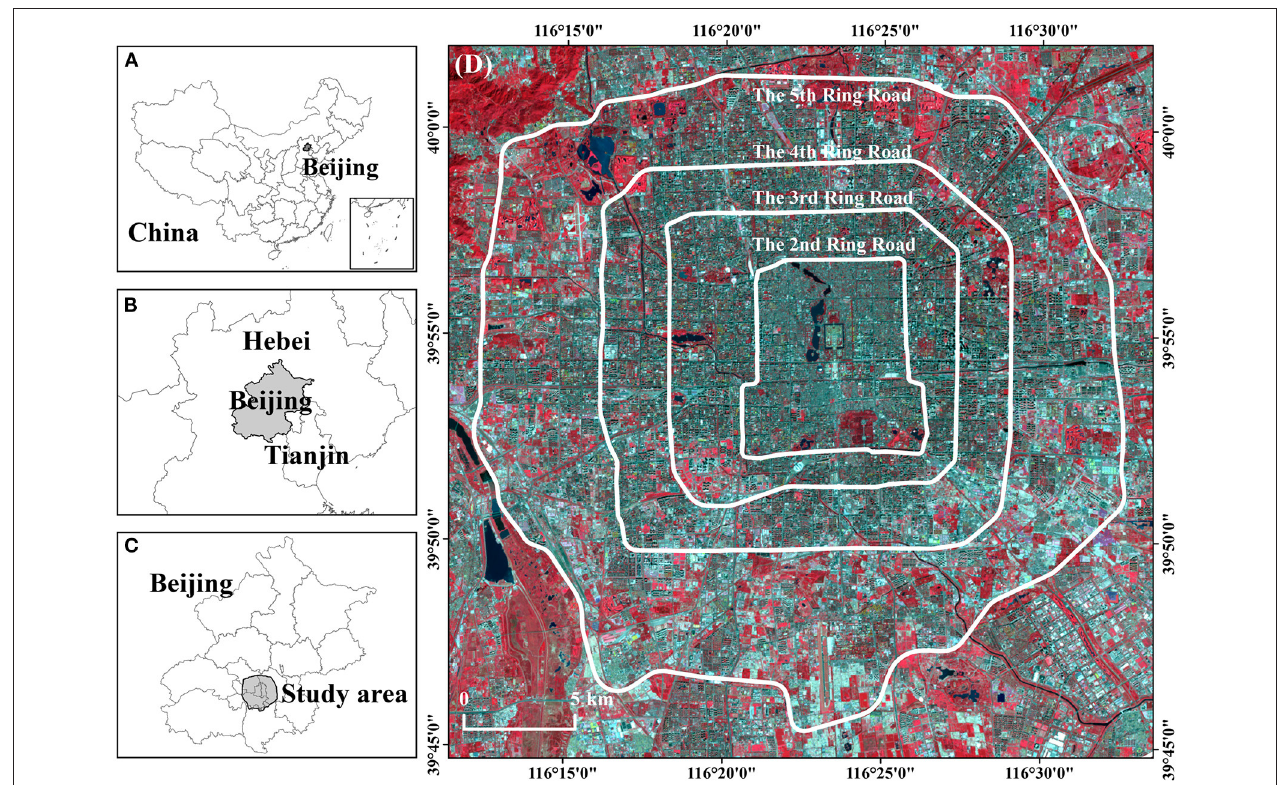
FIGURE 1 | Location of the study area in Beijing metropolitan area, China (A–C) . The Landsat8 remote sensing image (D) is displayed in false color mode, which is composed of band 5 (near-infrared), band 4 (red), and band 3 (green).